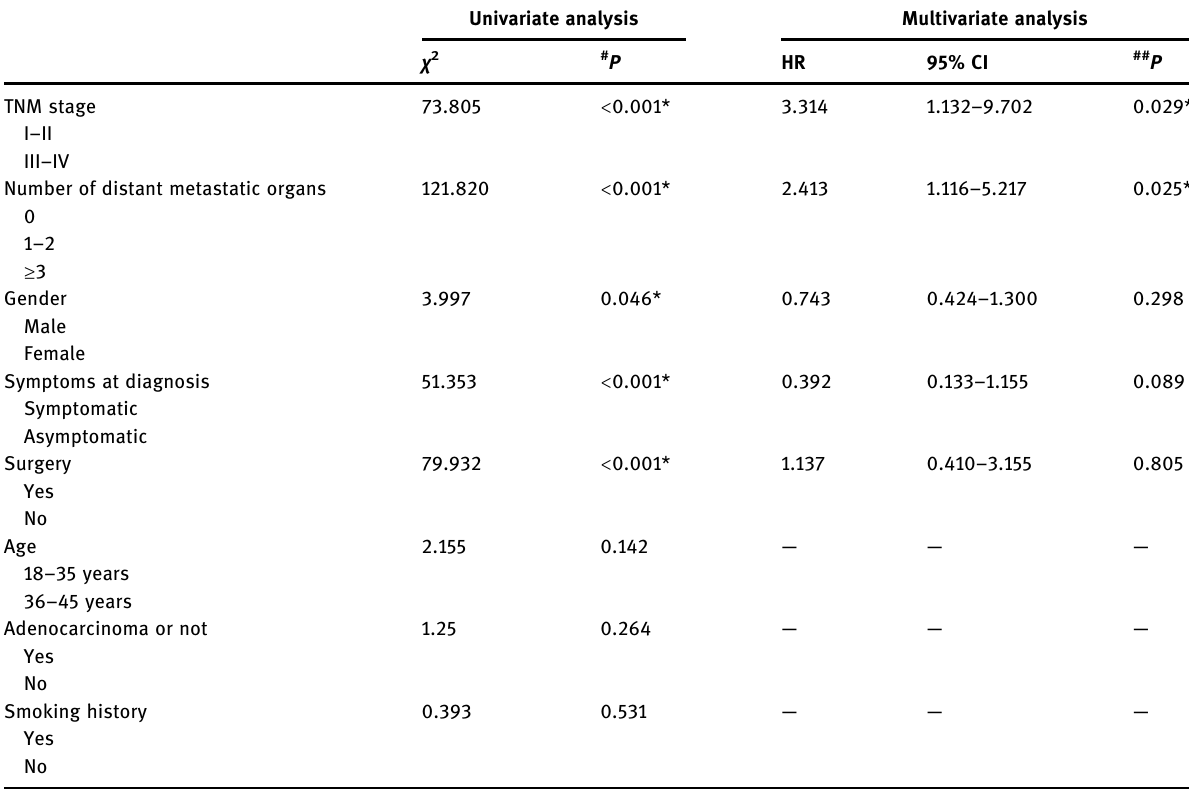
Table 4: Univariate and multivariate analysis for risk factors of OS in young patients with